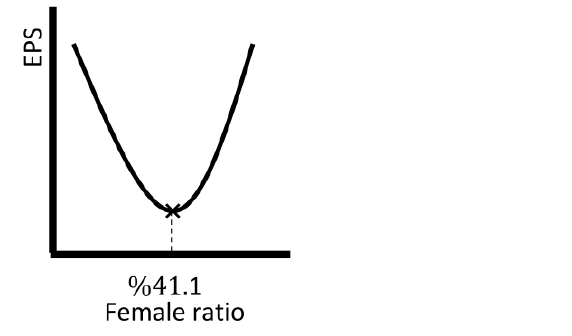
Figure 3. The critical female ratio in the full sample with respect to EPS.